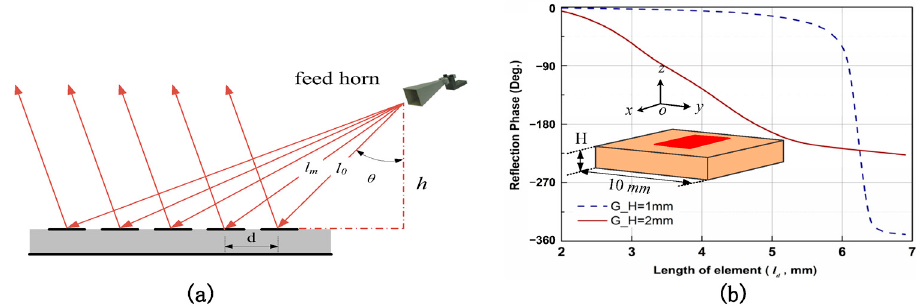
Figure 1. ( a ) Configuration of traditional reflectarray. ( b ) Reflection phase response for different substrates.